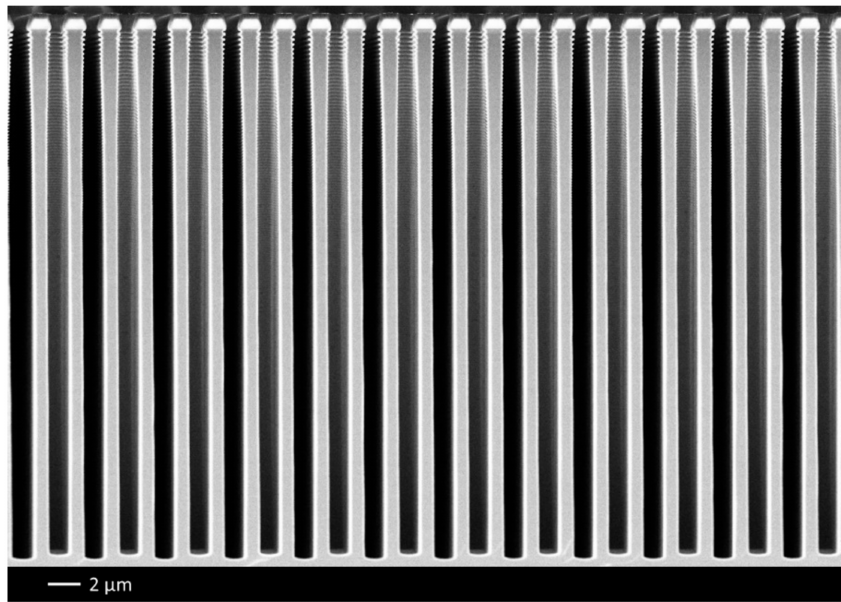
Figure 1. Deep trenches etched with the STiGer process—1 µ m SiO 2 mask, CD = 800 nm, depth = 30.7 µ m—1.5 s passivation (50 sccm SiF 4 , 50 sccm O 2 , 1500 W source, 30 V bias, 1.5 Pa), 3.5 s etch (150 sccm SF 6 , 1500 W source, 90 V bias, 3 Pa), 240 cycles, T = − 115 ◦ C, Alcatel 601E ICP